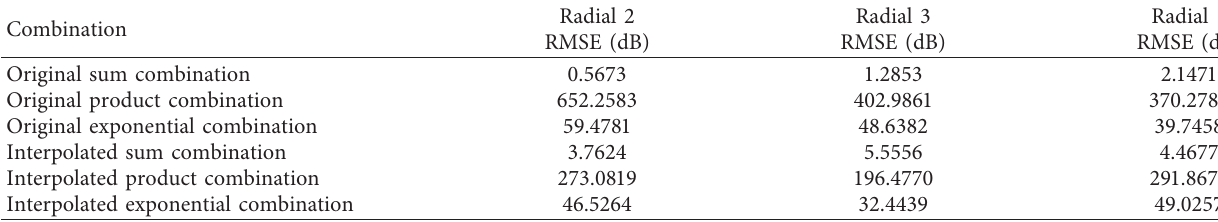
Table 4: RMSE values for different combinations for 􏽢 L and 􏽢 N